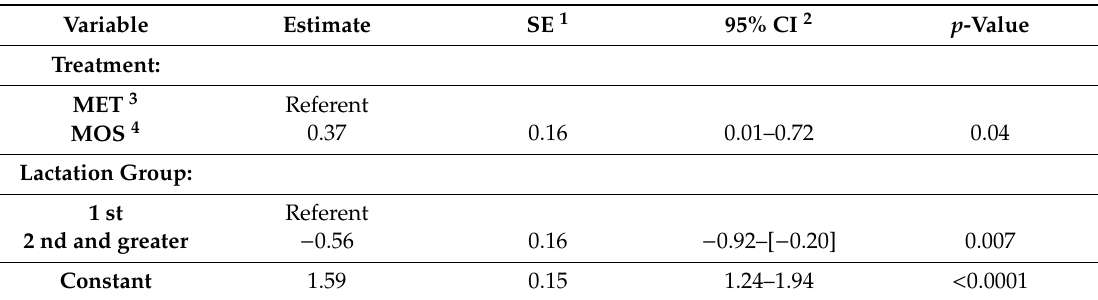
Table 5. Multivariable linear regression comparing maximum meloxicam plasma concentration ( µ g / mL) between MET- and MOS-treated cows.